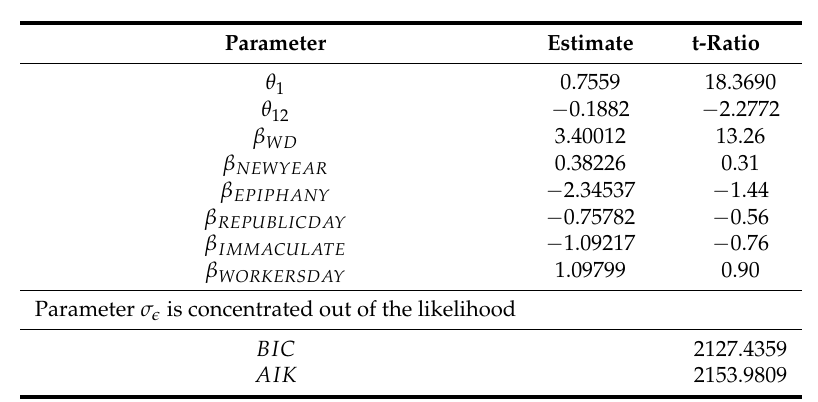
Table A19. Long weekend model dependent variable: IPI ( 0,0,1 )( 0,1,1 ) 12 nolog .